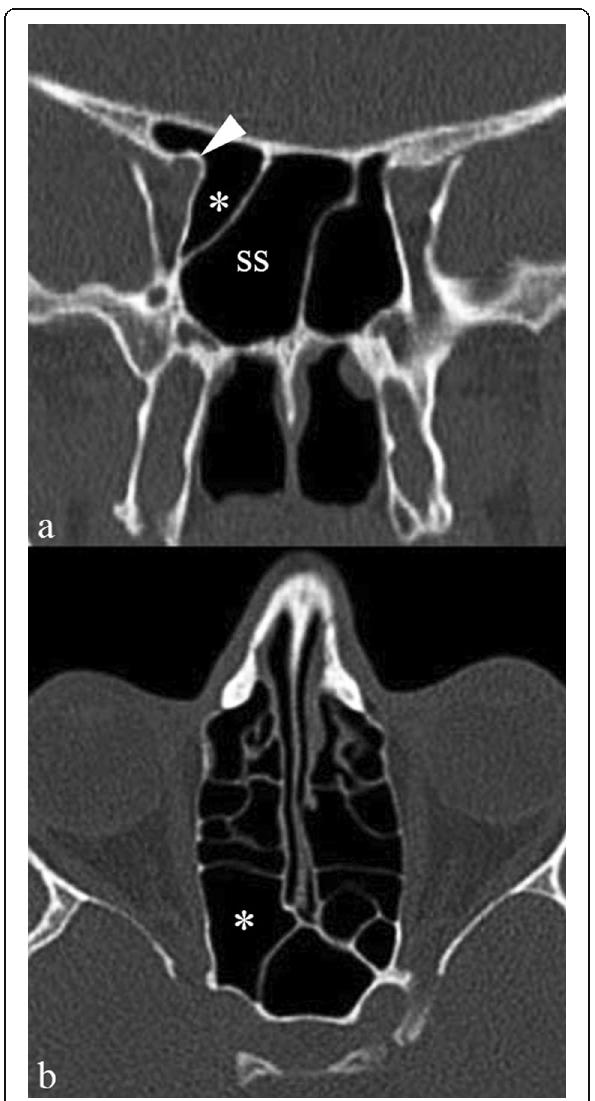
Fig. 1 Onodi cell. Coronal ( a ) and axial ( b ) MDCT images show a large air-cell (asterisk) along the superolateral aspect of the right sphenoid sinus (ss), corresponding to an Onodi cell. Pneumatization extends to the anterior clinoid process; consequently, the optic nerve canal protrudes slightly within the Onodi cell (arrowhead)